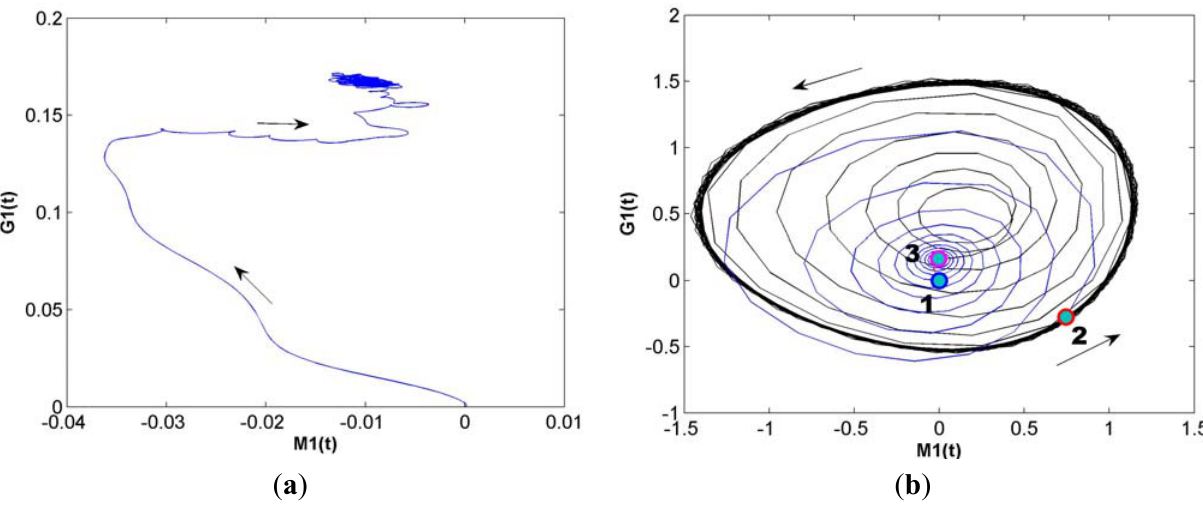
Figure 2. The trajectory in phase-space. ( a ) Before; ( b ) During stimulation.